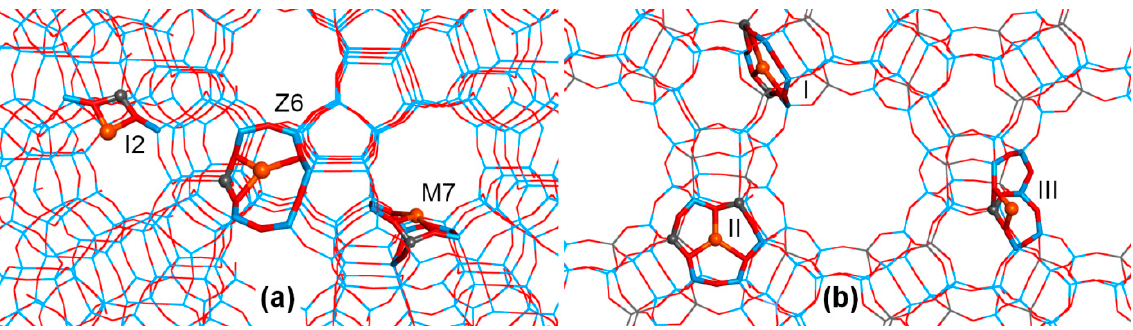
Figure 2. View of the lattices of zeolites ( a ) MFI and ( b ) FAU, with the main Cu(I) sites depicted (terminology for Cu(I) sites in MFI taken from Nachtigallová et al. 1999 [16]). The colors used for the atoms are: Cu—orange, Al—grey, Si—blue, O—red.